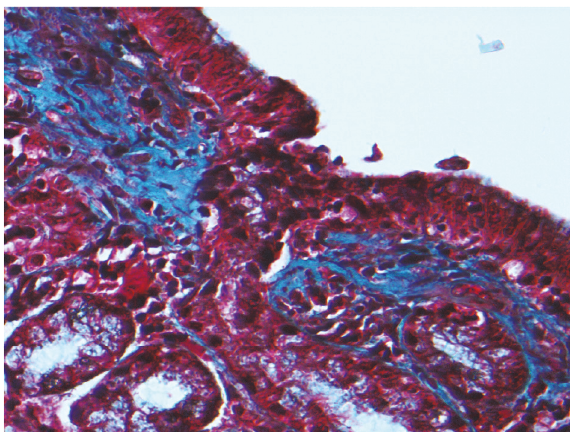
Figure 3: Histological section of gastric body showing area of subepithelial collagen deposition on trichrome